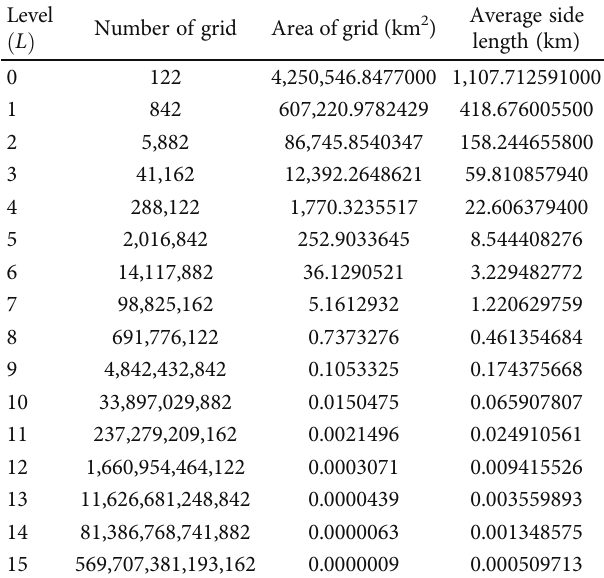
Table 2: Parameter statistics of the H3 grid (with a spherical radius of R = 6378 : 136km ).